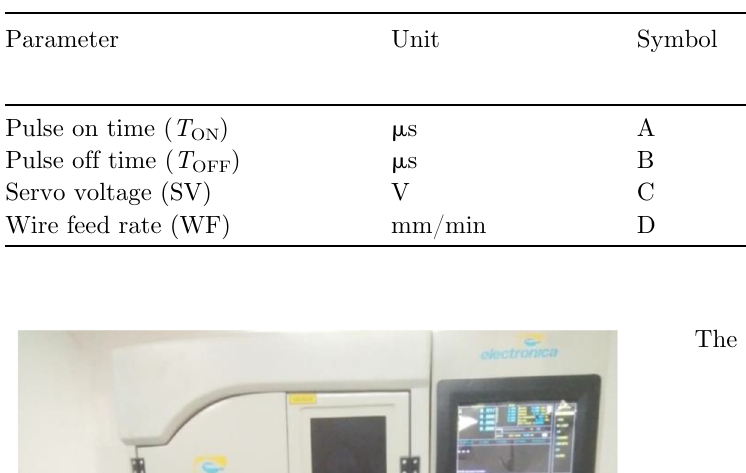
Table 2. Machining parameters and their